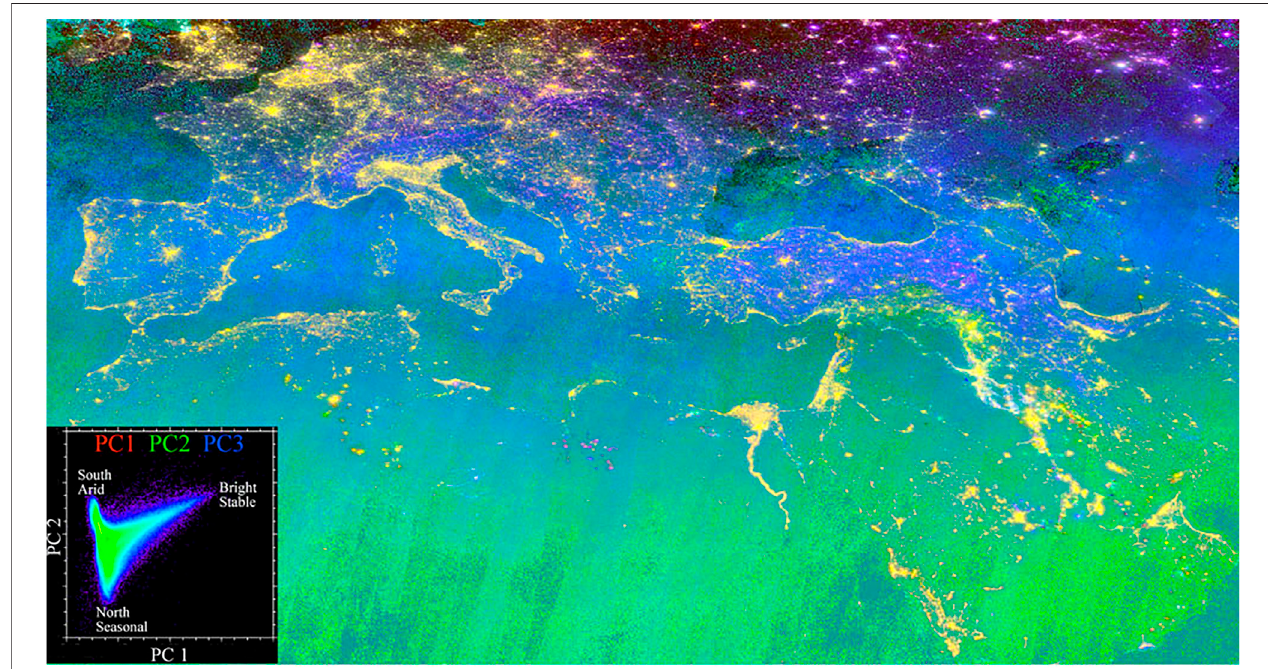
FIGURE4| Spatialprincipalcomponentsofthe2019+2020monthlytimeseriesforEurasia.PC1,PC2andPC3accountfor48%,26%and6%ofspatiotemporal variance (respectively). The temporal feature space (inset) shows PC1 corresponding to overall brightness and temporal stability as PC2 represents latitudinal variations in background luminance. PC3 also shows seasonal variability consistent with persistent winter snow cover in mountainous and steppe regions.